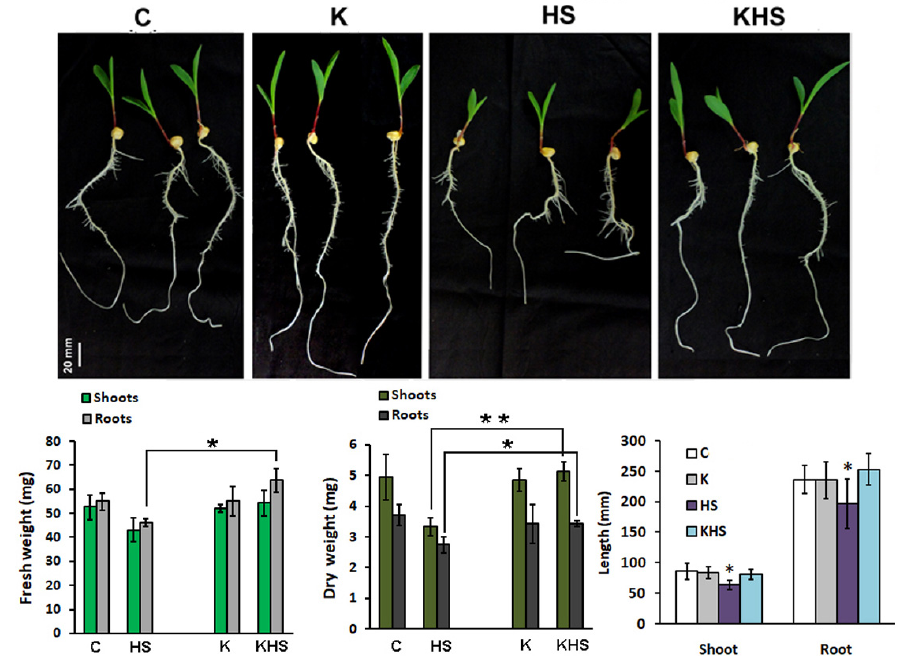
Figure 5. Phenotype and growth parameters (organ length, FW, and DW) of 11-day-old hydroponi- cally grown maize plants, 48 h after the applied heat shock (1 h at 45 ◦ C). C, control; HS, heat shock; K, treated with Kaishi (dilution 10 − 12 ) and grown under normal conditions; KHS, treated with Kaishi (dilution 10 − 12 ) and subjected to heat shock 24 h later. Asterisks designate statistically significant differences at p < 0.05 (*) and p < 0.01 (**). The error bars represent SD ( n ≥ 15, one-way ANOVA).